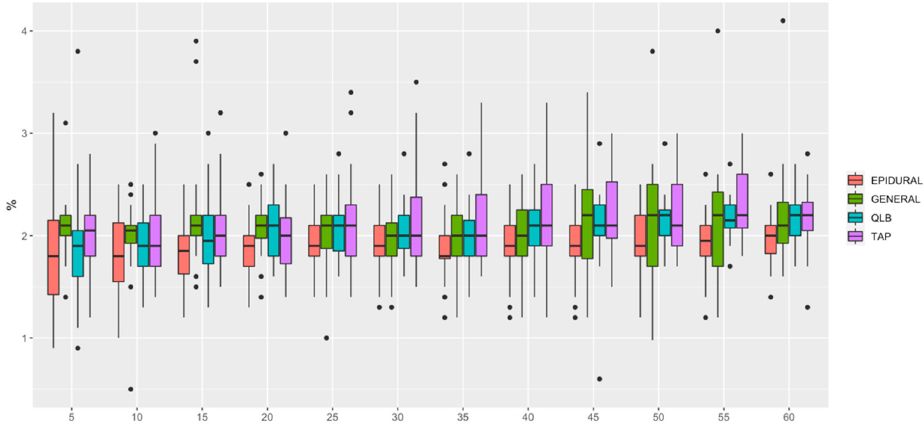
Figure 5. Graphic showing the different values of expired fraction of sevoflurane (FeSev) over the